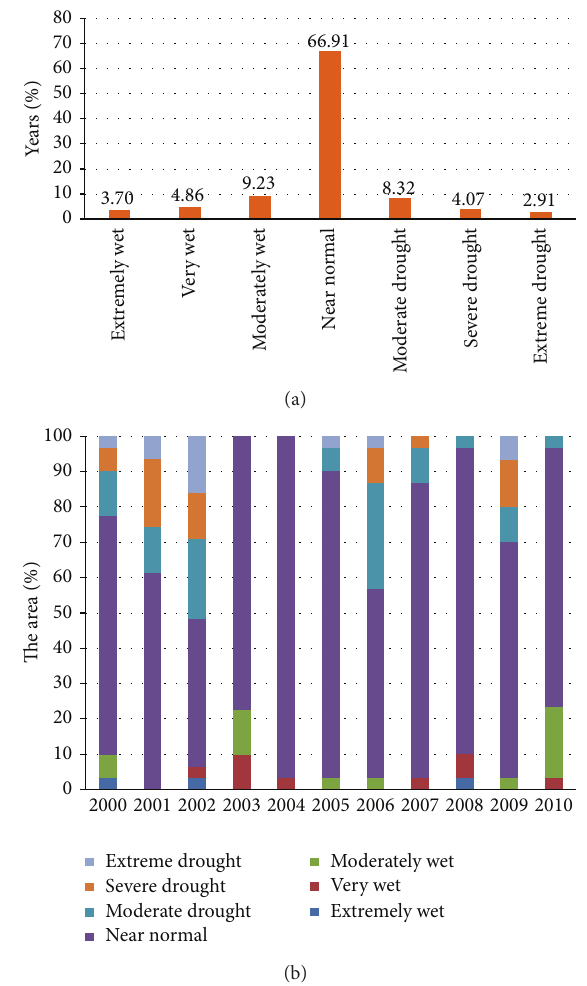
Figure 4: (a) Percentage of years affected by various drought severity levels, 1960–2010, and (b) percentage of BTHMA affected by drought, 2000–2010.